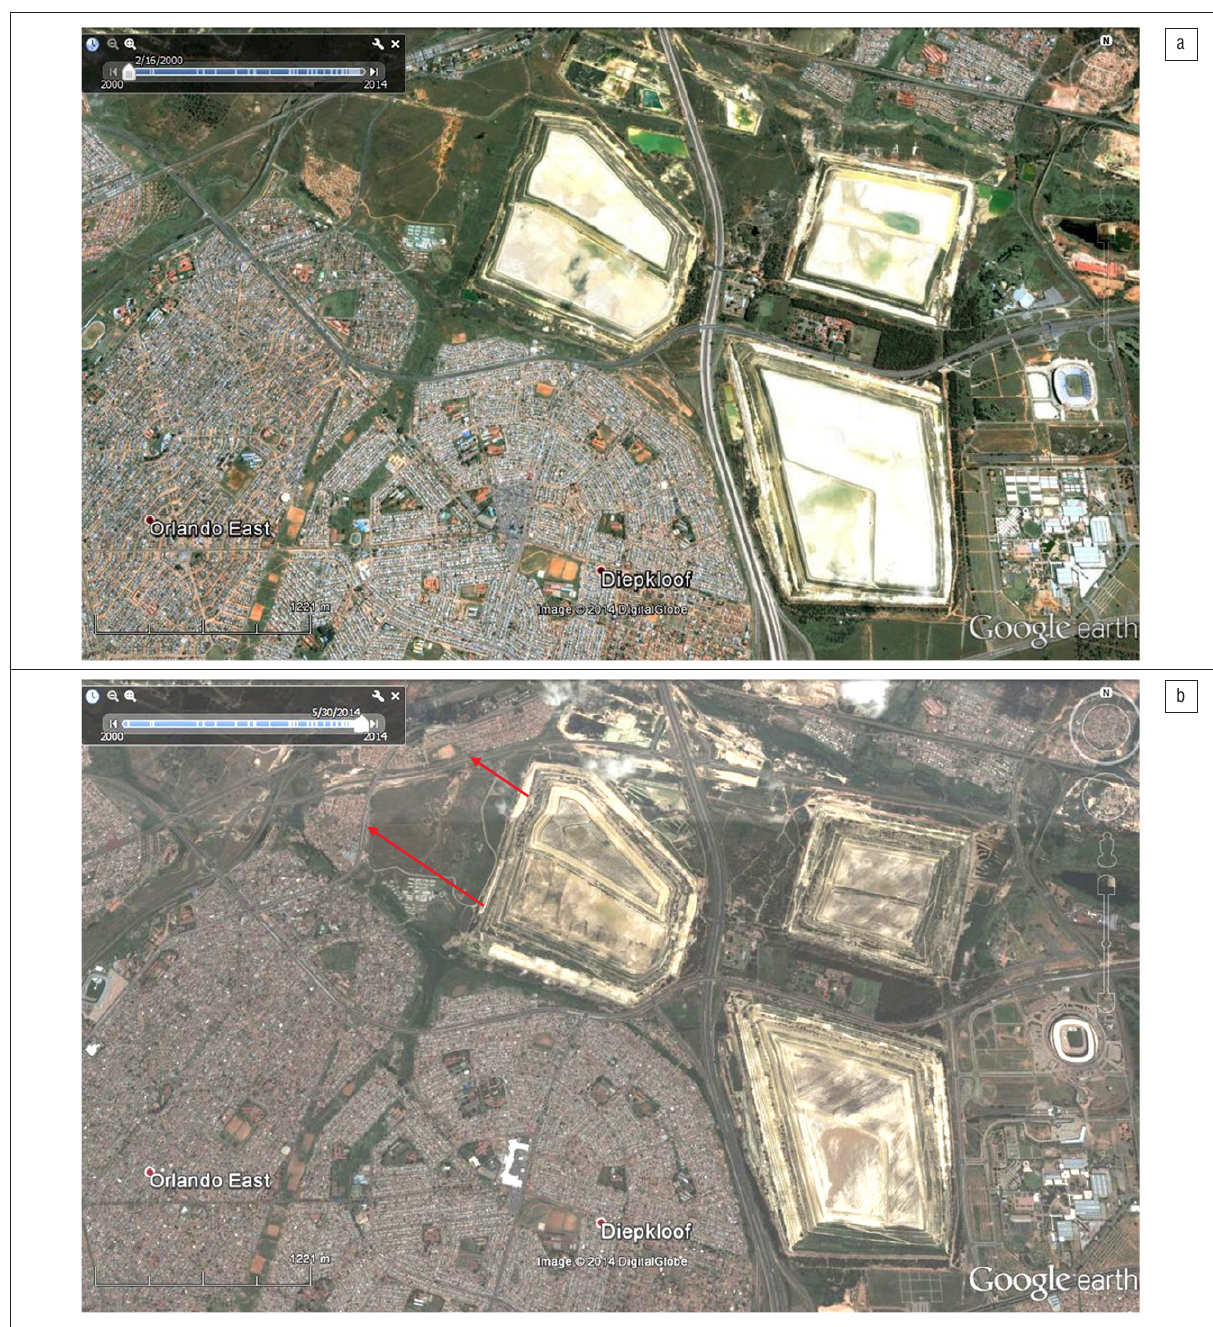
Figure 1: (a) February 2000 and (b) December 2013 Google Earth images showing newest residential developments close to Crown Gold Recoveries tailings storage facilities. Red arrows indicate newest housing using the calibrated and hand checked data to include all the TSFs in the of people (or households) per unit area by the area within that buffer city and across the Witwatersrand. Population densities, derived from zone (Figure 3a). 2001 census data 22 , and dwelling structure footprints from 2011 23 were The first step was to designate buffers around the required land use areas. used separately to estimate the regional impact of fine dust on residential areas adjacent to mine TSFs. These techniques to estimate automatically population numbers from census 22,23 and survey general topographic data, can be applied regionally or to any selected subset of locations. Two approaches were used to estimate the population living close to the TSF. The 2001 census data 22 , with the population densities (calculated as described previously), were intersected with the TSF buffers to compute population density polygons within each buffer zone. Within each buffer zone, the exposed population was calculated by multiplying the number